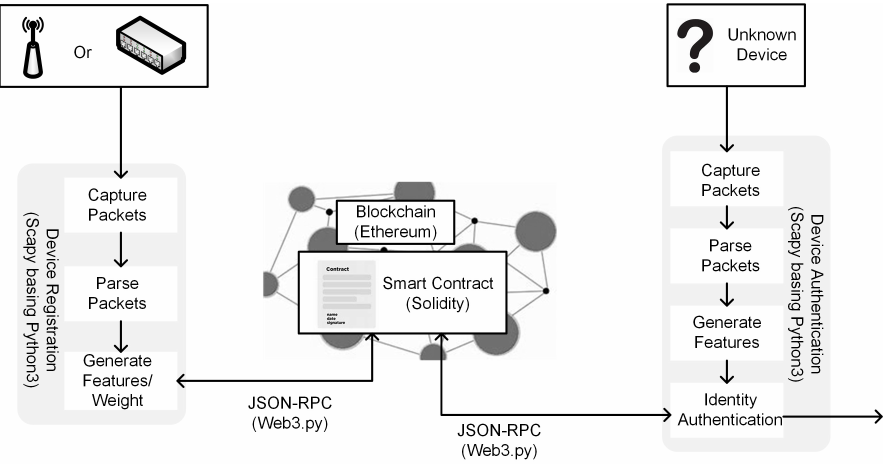
Figure 2. System